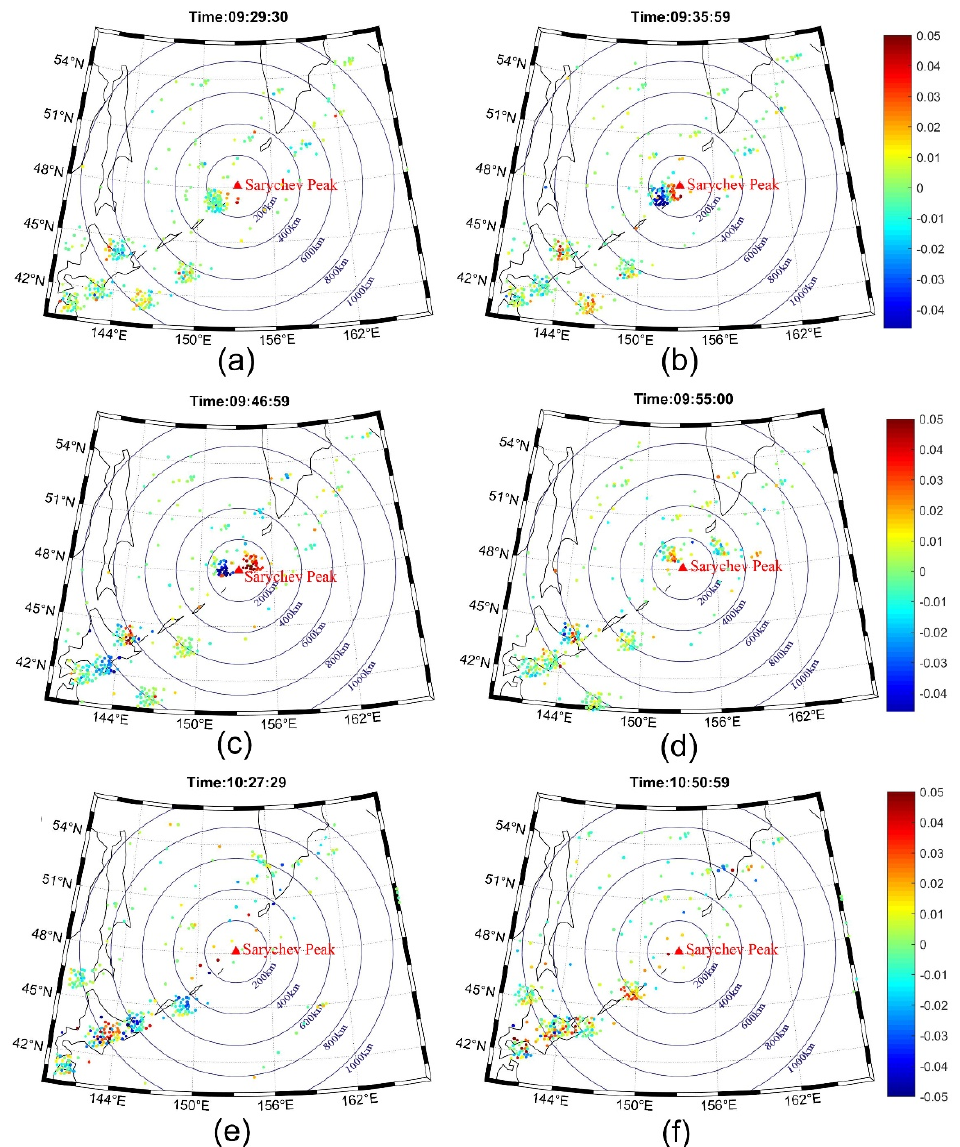
Figure 13. Examples of spatiotemporal evolution of the observed TEC disturbances initiated by 09:18 UT, 15 June 2009 explosion of Sarychev Peak volcano. ( a ) The first visible positive phase CVIDs triggered by the volcano explosion. ( b – d ) The near-field zone covolcanic TEC variation samples. ( e , f ) The far-field zone covolcanic TEC variation examples. The red triangle shows the location of Sarychev Peak volcano.